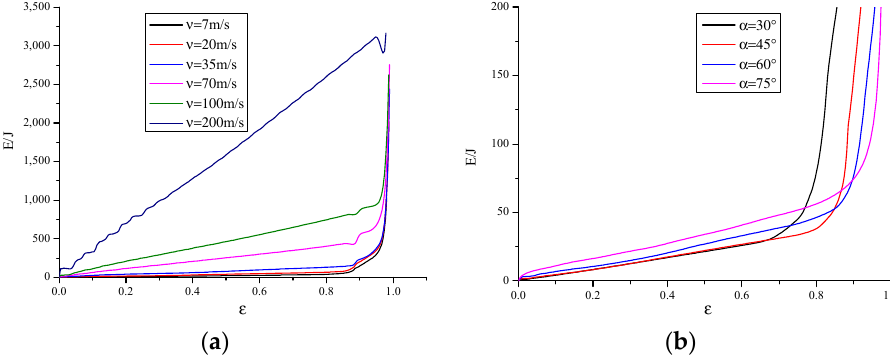
Figure 14. Relationship between energy absorption and strain of specimens. ( a ) E (total energy) with different velocities. ( b ) E (total energy) with different angles.